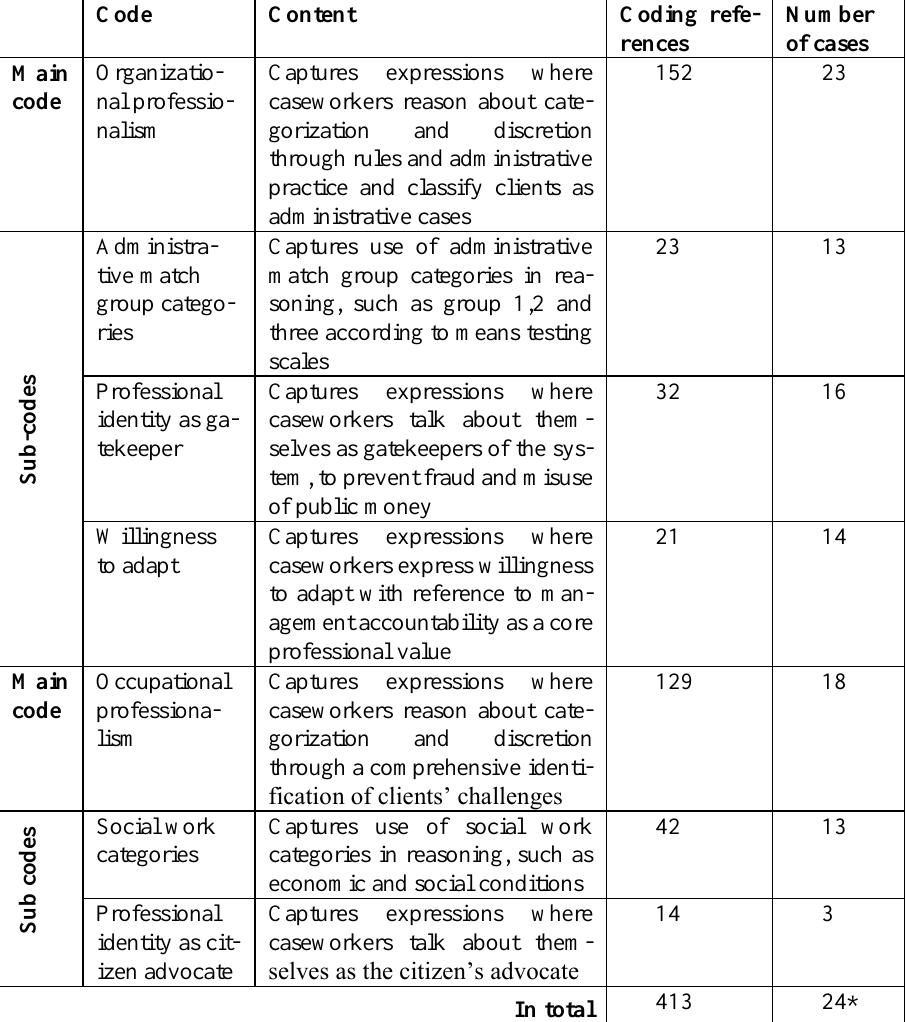
Table 3 Distribution of professional reasoning in